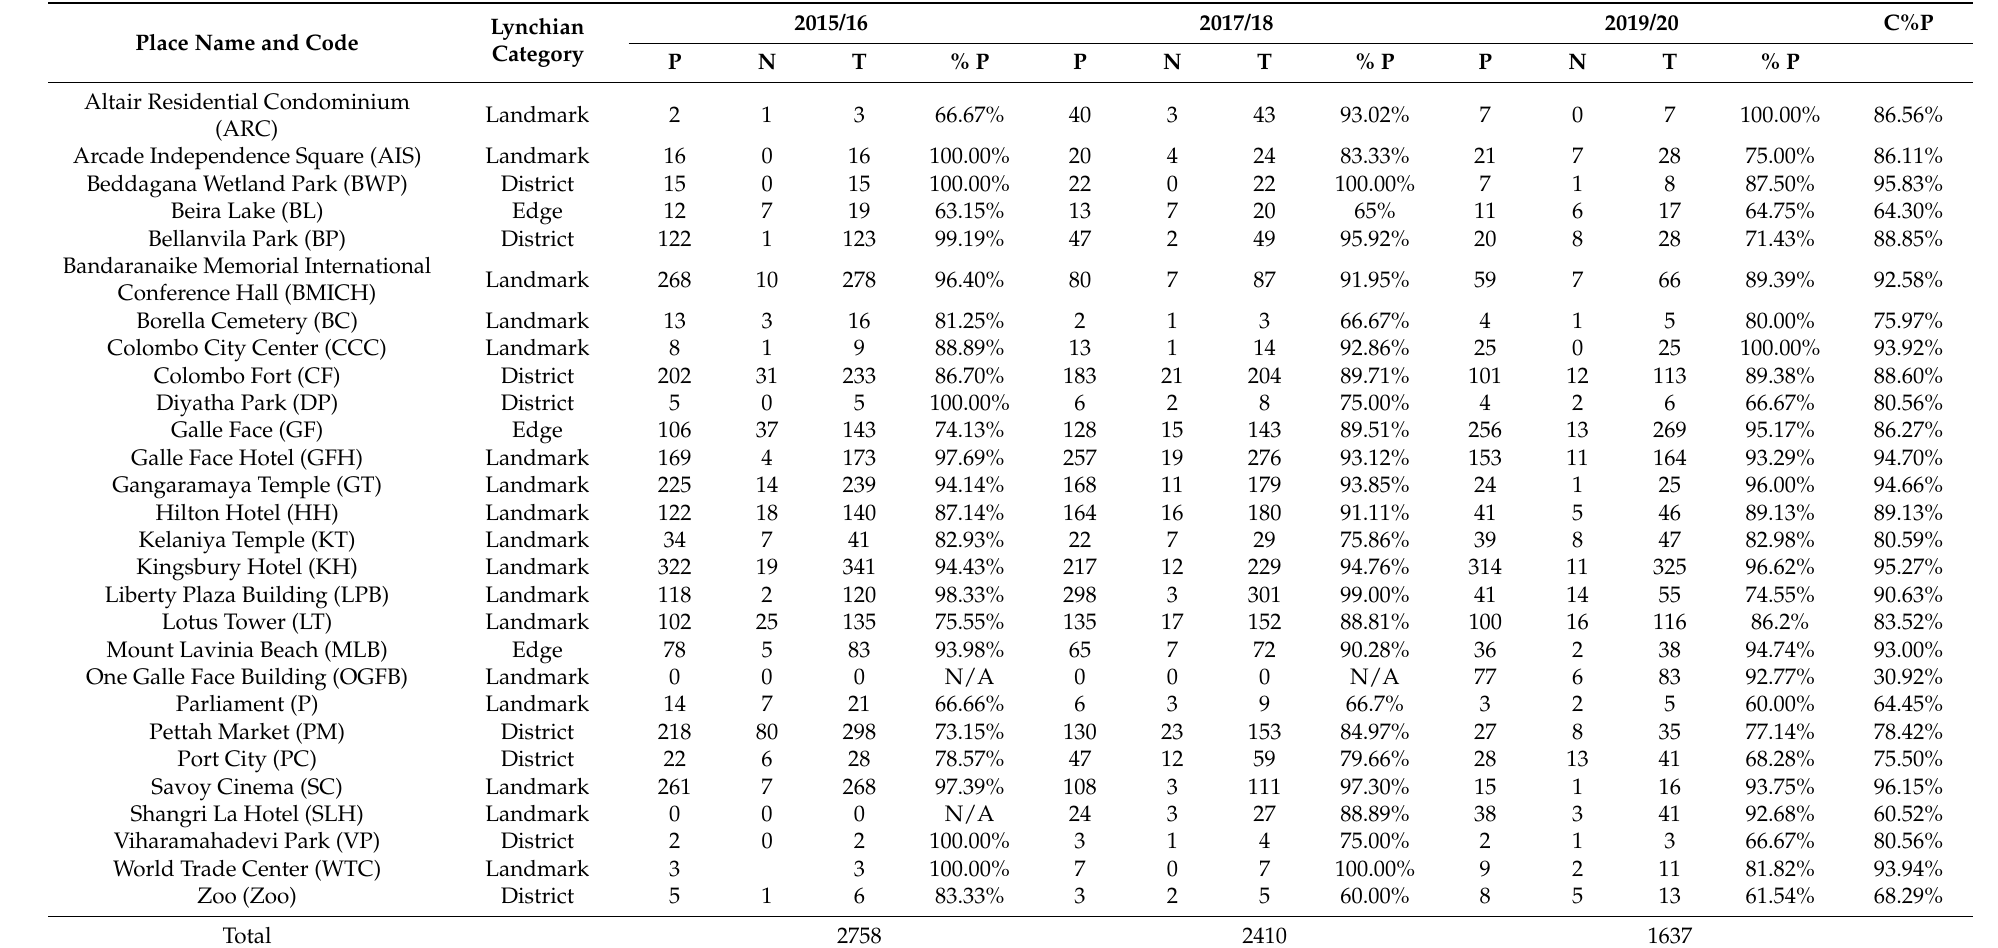
Table 2. Sentiment classification of